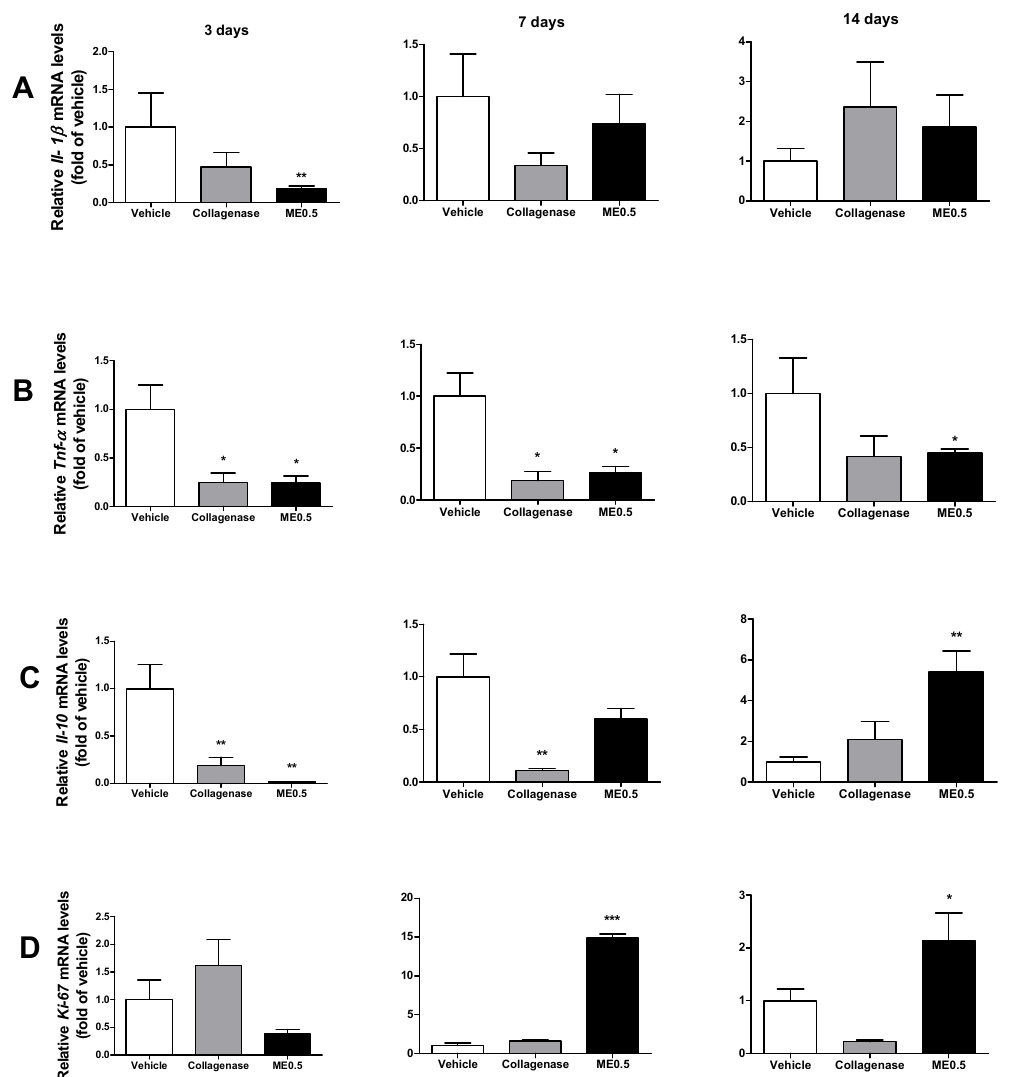
Figure 4. Levels of Il-1 β ( A ), TNF- α ( B ), IL-10 ( C ), and Ki-67 ( D ) mRNA expression in skin wounds after 3, 7, or 14 days of treatment with vehicle, collagenase cream, or ME0.5. ANOVA, Dunnett’s test; * p < 0.05, ** p < 0.01, *** p < 0.001.